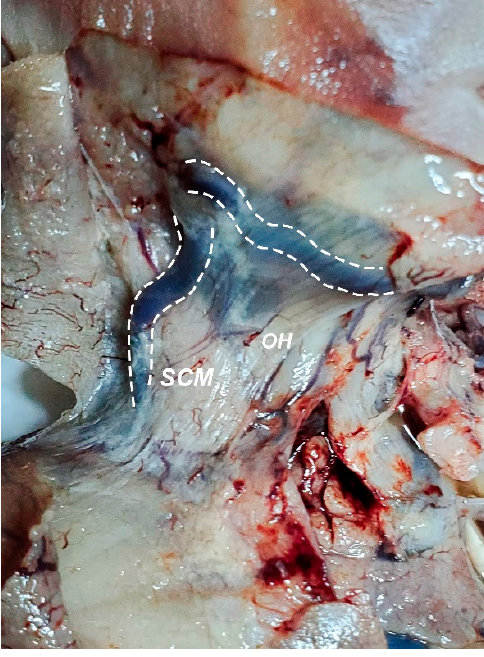
Figure 7 . Neck, right view; skin was removed. Dashed lines highlight linguo-facial trunk (up) and external jugular vein (left), which are visible through the transparency of the platysma; Bluish coloration of the carotid triangle is due to the dilation of the internal jugular vein; SCM—sternocleidomastoid muscle; OH—omohyoid muscle.